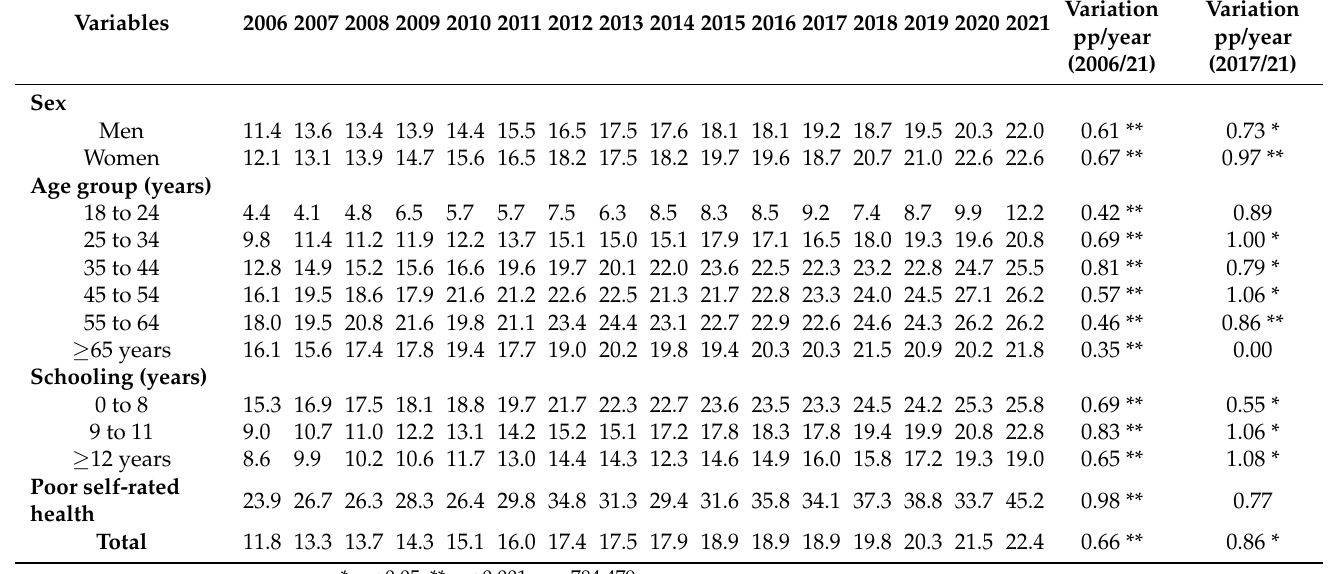
Table 1. Prevalence (%) of obesity among Brazilian adults ( ≥ 18 years), by year, according to sociode- mographic characteristics and self-rated health. Vigitel Brazil,